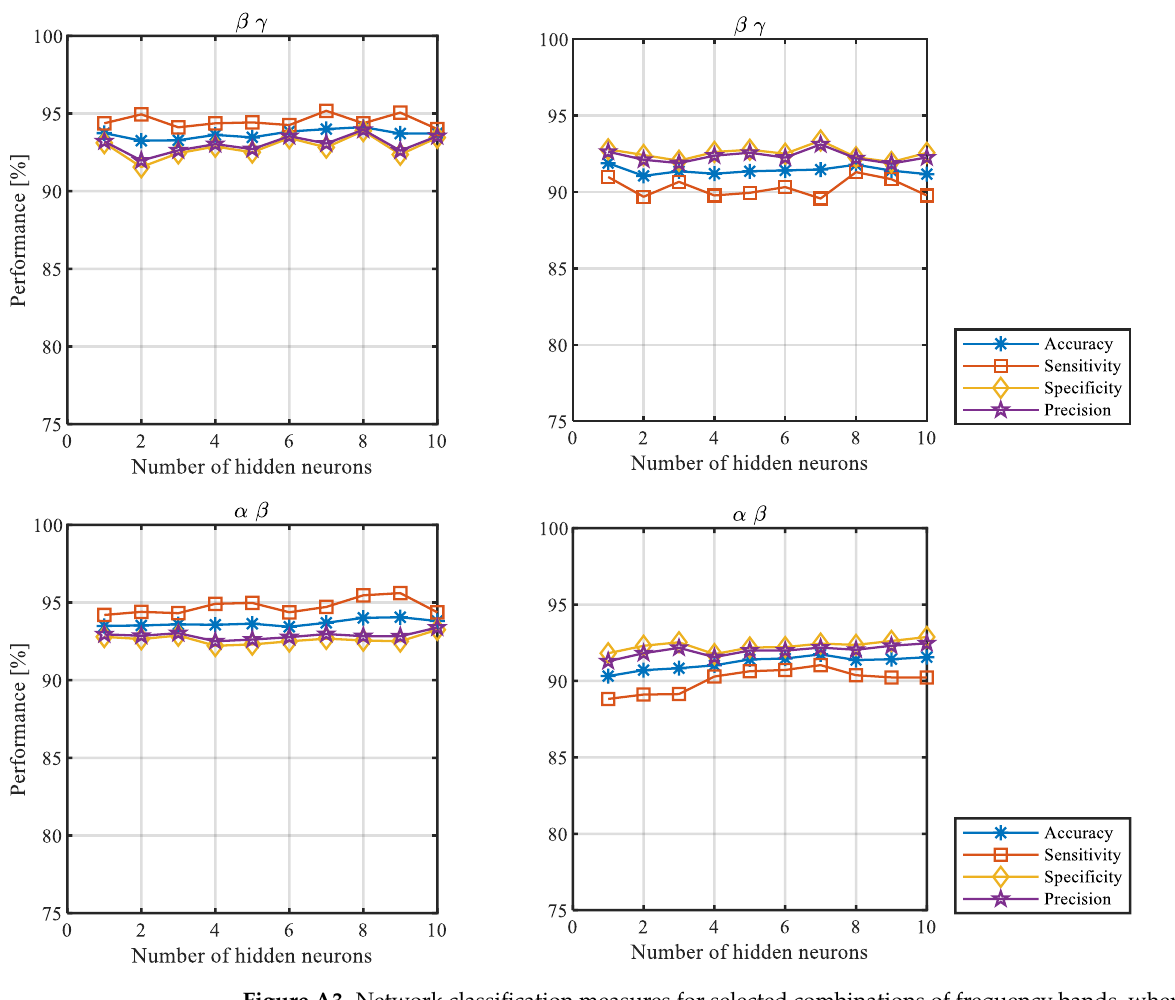
Figure A3. Network classification measures for selected combinations of frequency bands, where the training and testing feature set vectors were separated by different parts of the same sessions ( left , the first scenario) and different sessions ( right , the second scenario).